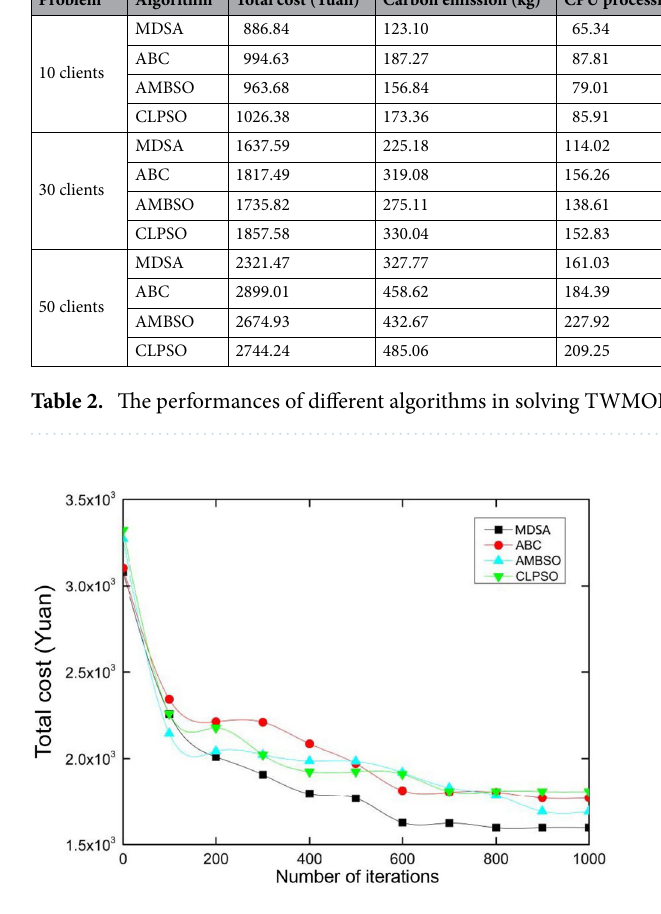
Figure 2. Comparison of algorithms in convergence.